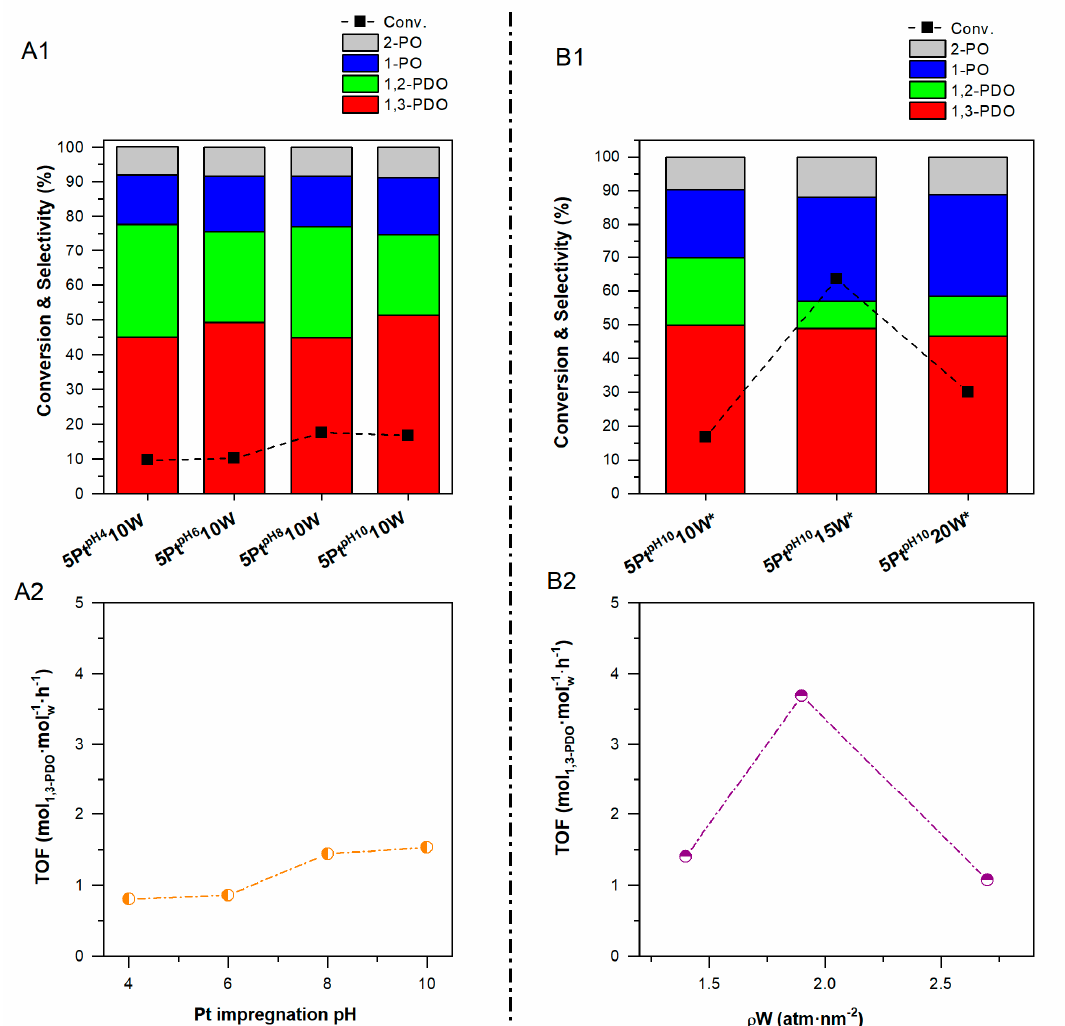
Figure 2. Performance of Pt-WO x / γ -Al 2 O 3 catalysts in glycerol hydrogenolysis. Left: Effect of the Pt impregnation pH on glycerol conversion and product selectivity ( A1 ), and on TOF 1,3-PDO-W ( A2 ). Right: Effect of the ρ W on glycerol conversion and product selectivity ( B1 ), and on TOF 1,3-PDO-W ( B2 ). Operating conditions: 473 K, 55 MPa H 2 , 5 wt.% glycerol water solution, 0.3 g cat · g glycerol − 1 , 4 h.